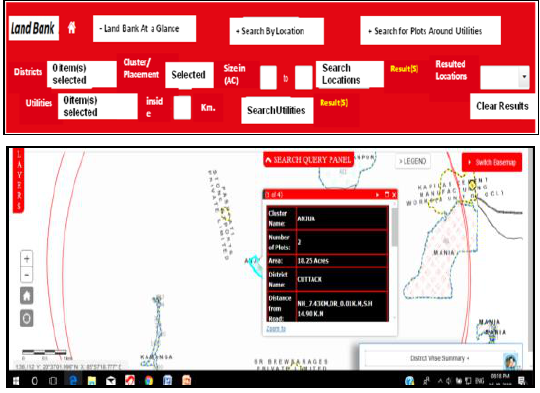
Figure 6. Land Bank Search Module to provide utilities location around a selected sites with buffer in Km.